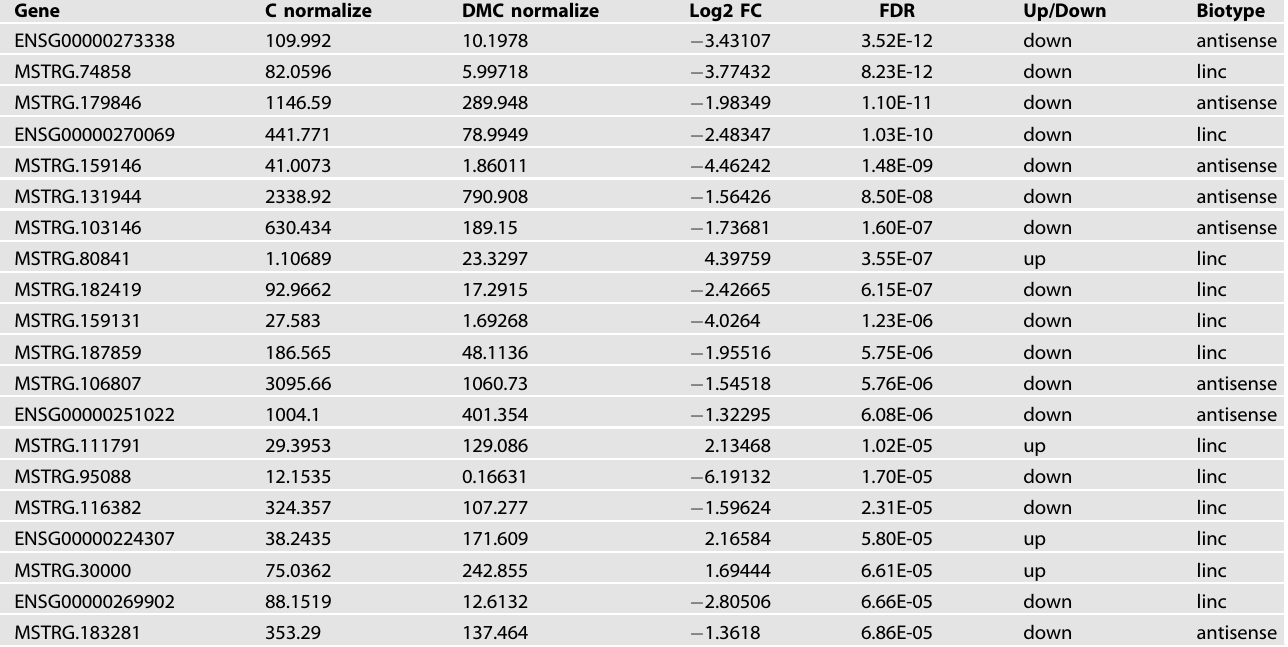
Table 2. The top 20 lncRNA with signi fi cantly differential expression in white blood cell from diabetes with macrovascular complication (DMC) and health control